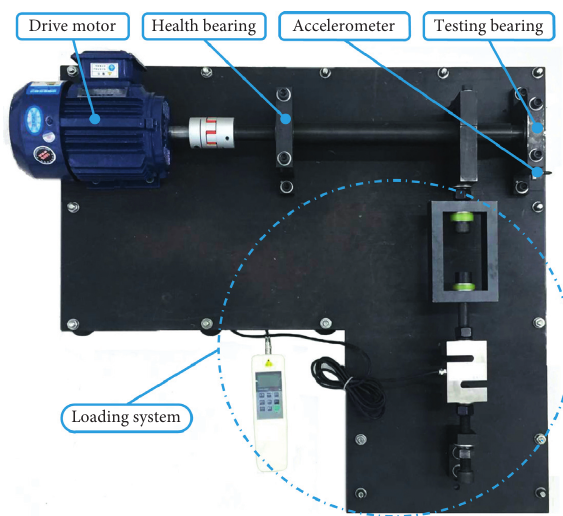
Figure 4: Bearing test platform.